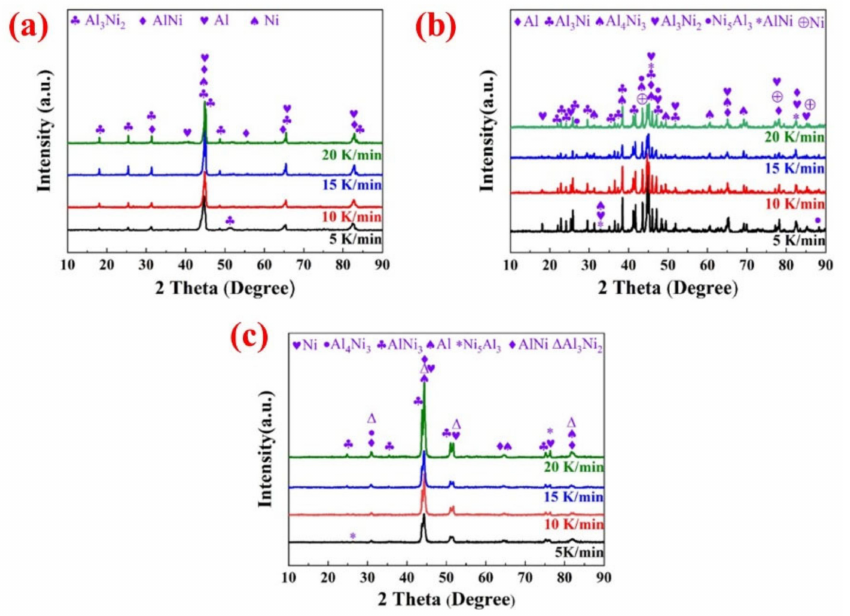
Figure 3. XRD results: ( a ) Ni/Al = 1:1, ( b ) Ni/Al = 1:3, and ( c ) Ni/Al =